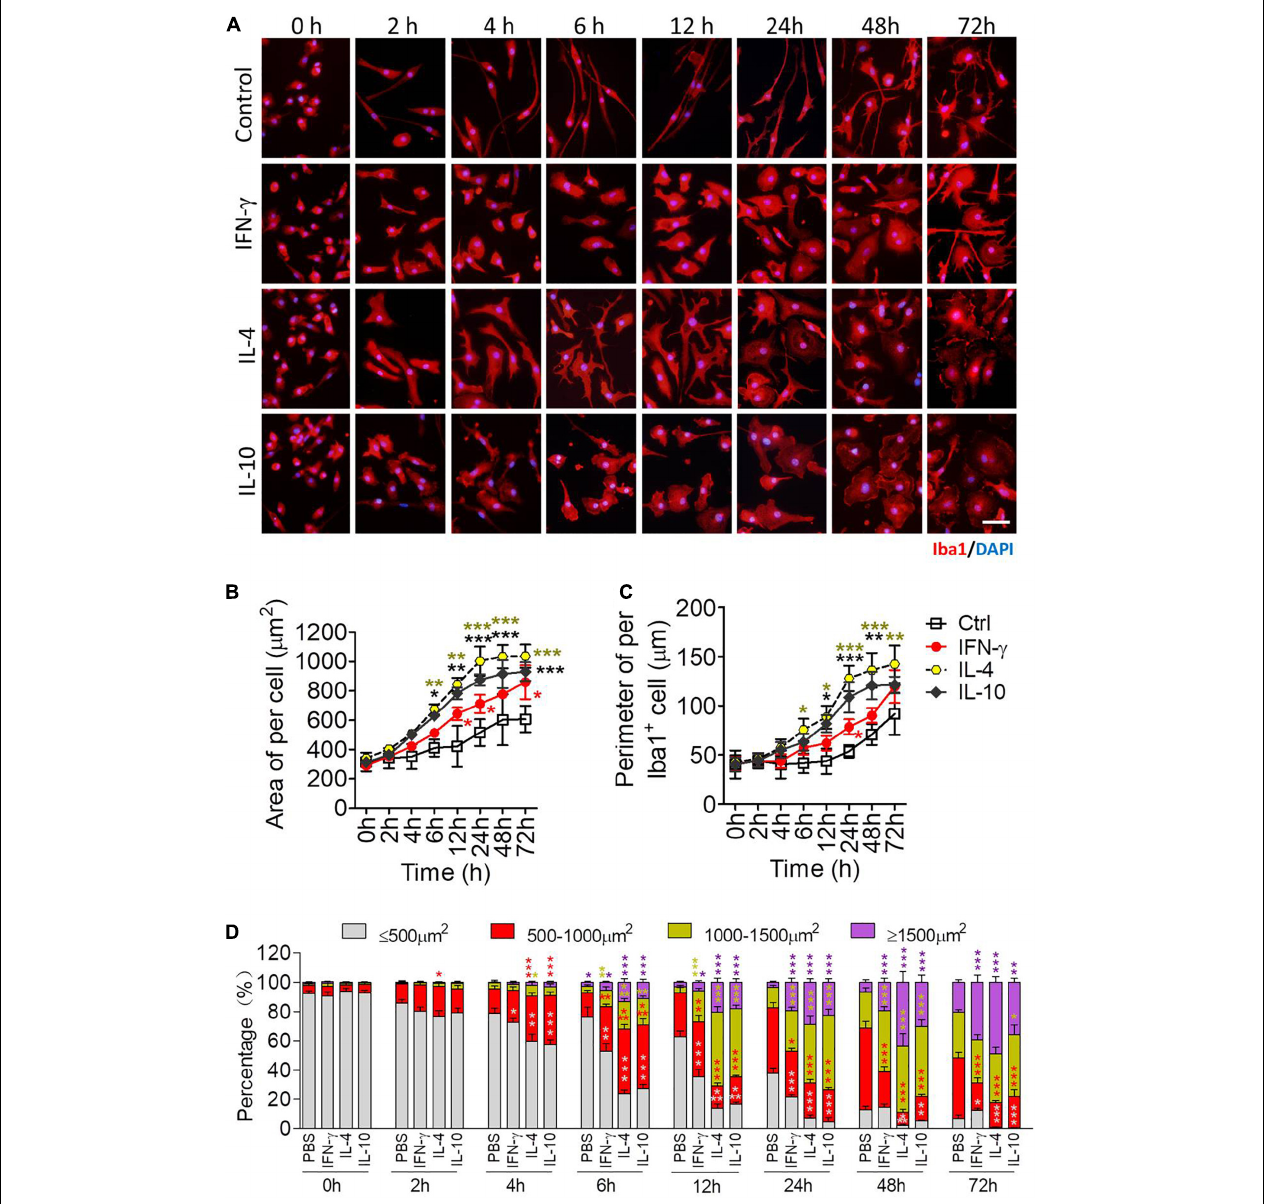
FIGURE 4 | Morphological definition of microglial phenotypes induced by IFN- γ , IL-4, or IL-10. (A) Microglial morphology in response to treatment with IFN- γ , IL-4, or IL-10 for the indicated times. Microglia were immunolabeled for Iba1 (red), and nuclei were labeled with DAPI (blue). (B) Microglial area after treatment with IFN- γ , IL-4, or IL-10 treatment for 2–72 h. (C) Microglial diameter after treatment with IFN- γ , IL-4, or IL-10 for 2–72 h. (D) Size distribution of microglia after treatment with IFN- γ , IL-4, or IL-10 for 2–72 h. Five, 40 × micrographs were taken from each well, and all cells in the field were measured. Data are presented as mean ± SEM ( n = 4 well per group), * P < 0.05, ** P < 0.01, *** P < 0.005 (one-way ANOVA with Tukey’s multiple-comparisons